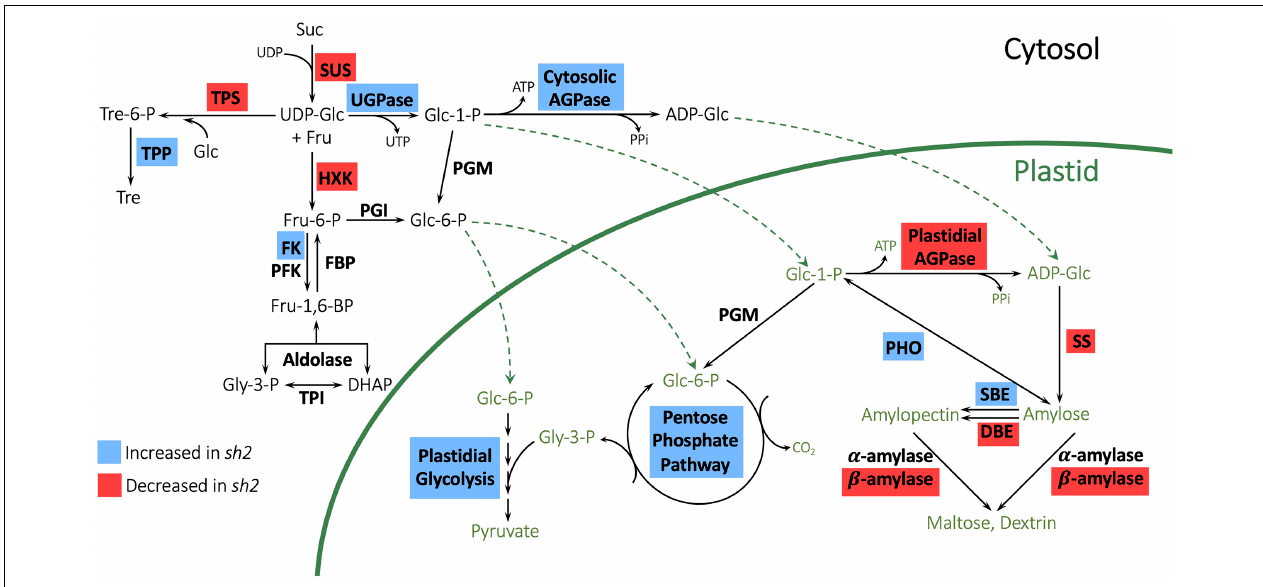
FIGURE 3 | Expression changes of genes in the starch biosynthetic pathway in maize endosperm. Enzymes with gene expression changes in sh2 endosperm are indicated with colored backgrounds. Blue boxes indicate increased expression in sh2 endosperm, while red boxes indicate decreased expression in sh2 endosperm. Suc, sucrose; Fru, fructose, Glc, glucose; Tre, trehalose; Glc-1-P, glucose 1-phosphate; Glc-6-P, glucose 6-phosphate, Fru-6-P, fructose 6-phosphate; Fru-1,6-BP, fructose 1,6-bisphosphate; Tre-6-P, trehalose 6-phosphate; Gly-3-P, glycerol 3-phosphate; DHAP, dihydroxyacetone phosphate; PPi, pyrophosphate; ADP-Glc, ADP glucose; UDP-Glc, UDP glucose; SUS, sucrose synthase; UGPase, UDP-glucose pyrophosphorylase; AGPase, ADP-glucose pyrophosphorylase; HXK, hexokinase; FK, fructokinase; PFK, phosphofructokinase; FBP, fructose 1,6 bisphosphatase; TPI, triose phosphate isomerase; PGM, phosphoglucomutase; PGI, phosphoglucoisomerase; PHO, starch phosphorylase; SS, starch synthase; SBE, starch branching enzyme; DBE, debranching enzyme; TPS, trehalose-6-phosphate synthase; TPP, trehalose-6-phosphate